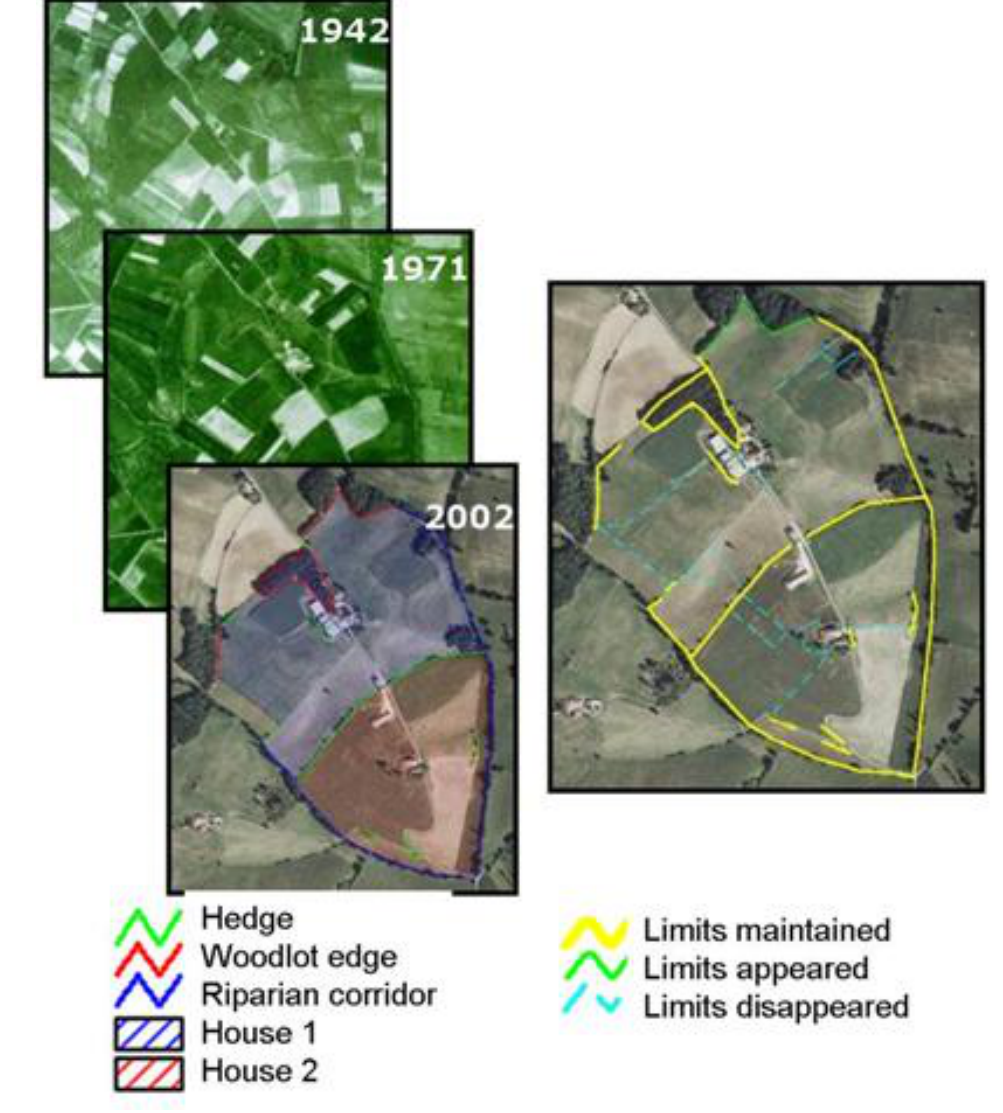
Fig. 2. The dynamics of human and ecological limits. A fine-scale ethnological study, combining historical maps of land registration, “house” history acquired from interviews, and aerial photographs identifying social units (houses) and ecological features (hedges, woodlot edges, riparian corridors) that may be used to define limits (maps on the left). The historical analysis (right-hand map) shows that most of thewithin-house limits have disappeared, whereas inter-house limits have been maintained or created between 1942 and 2002. This example illustrates how social constraints shape the landscape and may influence ecological processes, because hedges, woodlots, and riparian corridors are known to be of prime importance for biodiversity dynamics in fragmented landscapes. Such a study needs detailed data that cannot easily be obtained for a large area; it has been repeated for 43 houses. Credit: INRA; IGN, BD ORTHO,